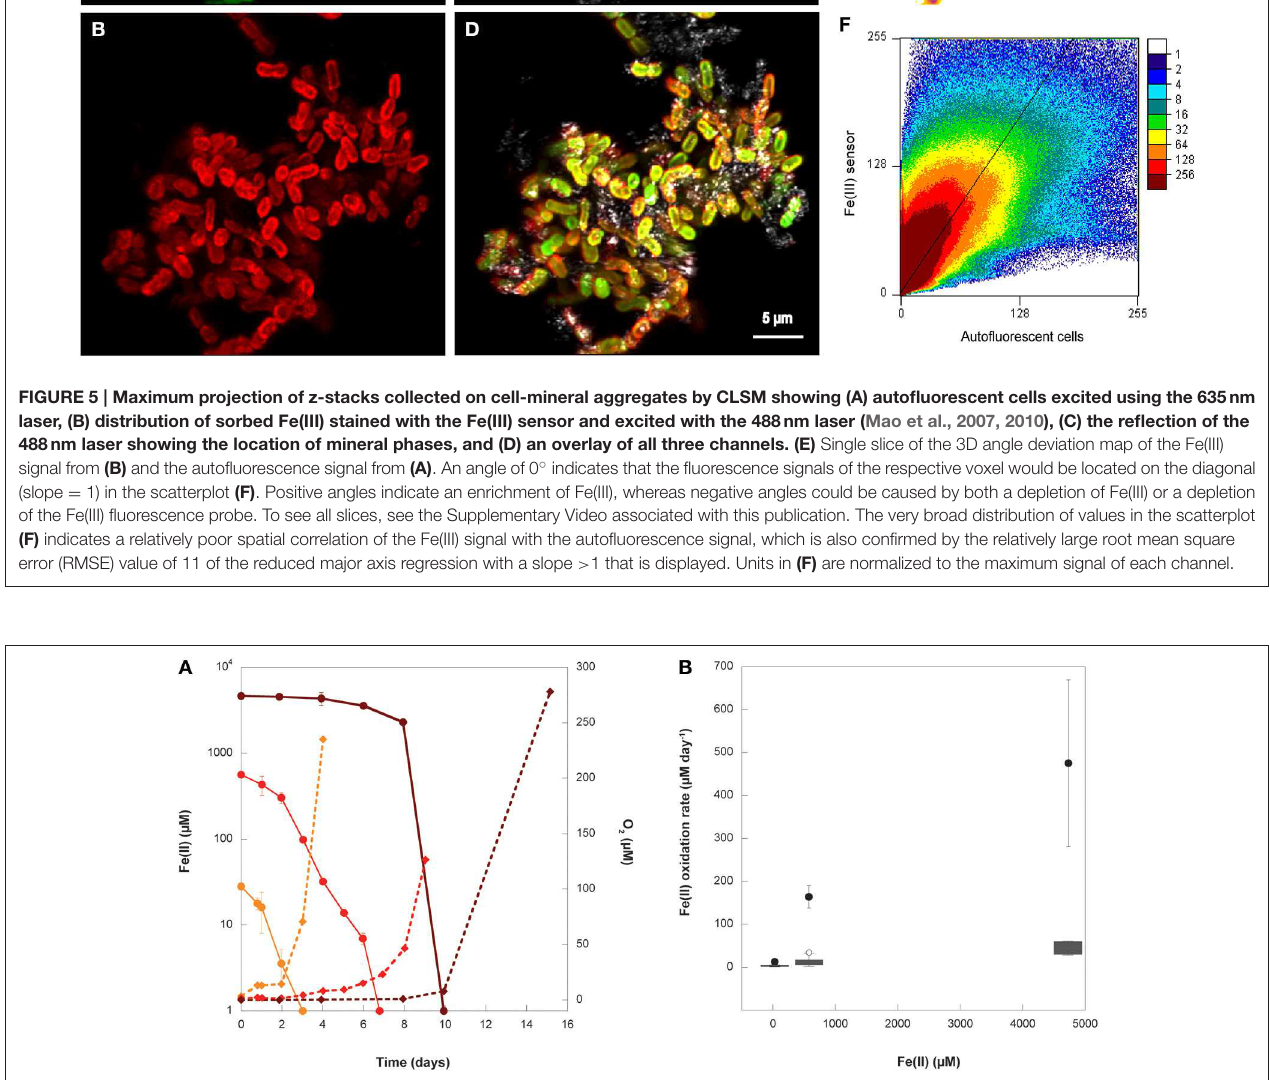
Frontiers in Earth Science |